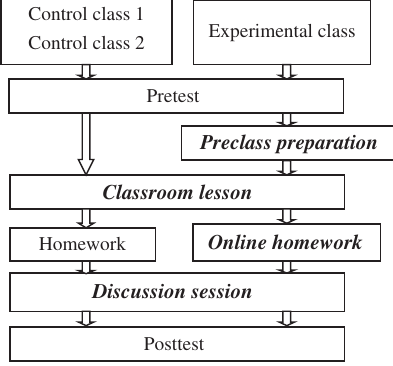
FIG. 1. A schematic representation of the experimental study